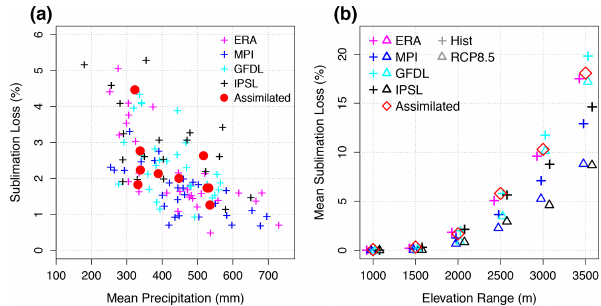
Figure 8. (a) Fraction of annual precipitation lost by sublimation against total annual precipitation in the MRCM downscaled exper- iments forced with ERA-Interim (1982–2011, magenta), the three GCMs (1976–2005): MPI-ESM-MR (blue), GFDL-ESM2M (cyan) and IPSL-CM5A-LR (black), and the assimilated snow run forced with MODIS and TRMM data only (red, data from T20a). (b) Frac- tion of annual precipitation lost by sublimation as a function of al- titude range in our study area, for the assimilated run from T20a and in the various downscaled experiments, for historical (1976– 2005, “ + ”) and RCP8.5 (2071–2100, “ (cid:49) ”) scenarios.